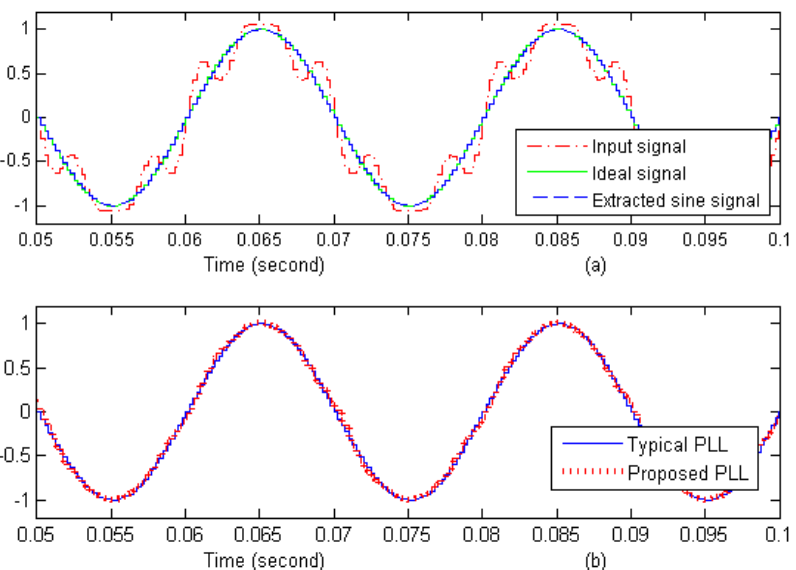
Figure 5. The orthogonal signals generator: ( a ) comparison between ideal signal and produced sine signal using wavelet-based PLL; ( b ) comparison of produced sine signals using the proposed PLL and a typical PLL.